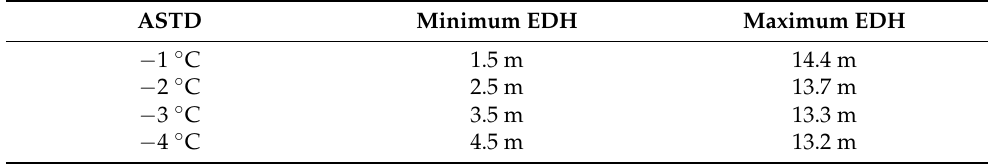
Figure 15. Typical results from the sensitivity analysis of the EDH to the ASTD and WS. Table 3. Ranges of EDH under different ASTD.